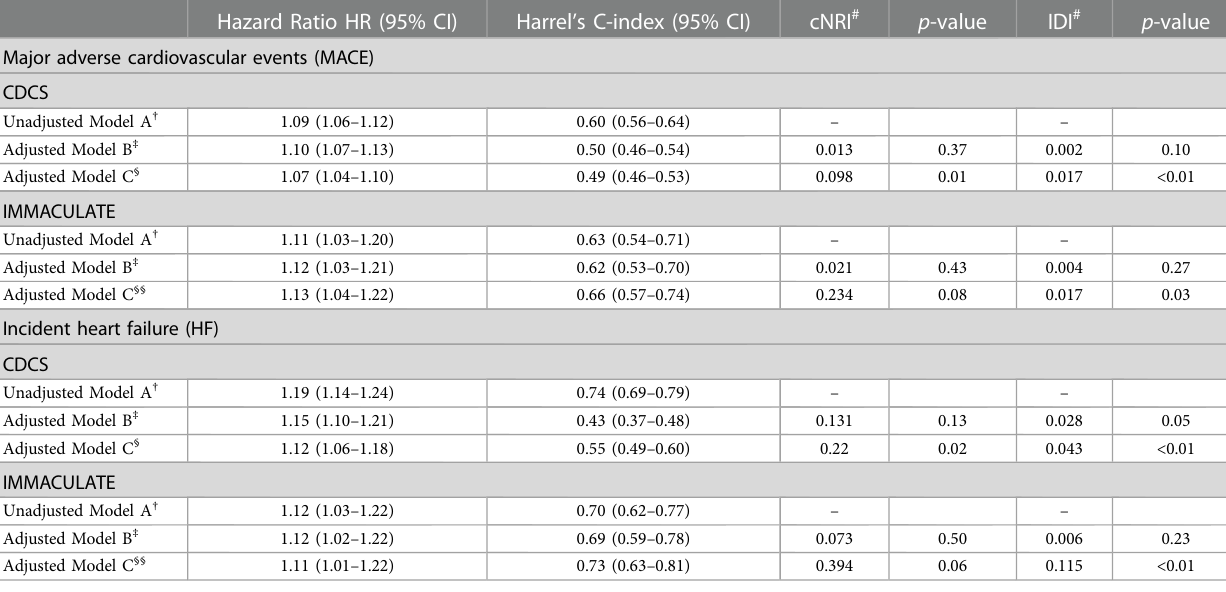
TABLE 5 The hazard ratios (HR), C-index, continuous net reclassi fi cation index (cNRI) and the integrated discrimination index (IDI) of classi fi cation probability scores from MACE and HF network signatures, adjusting for clinical variables and medication use at hospital